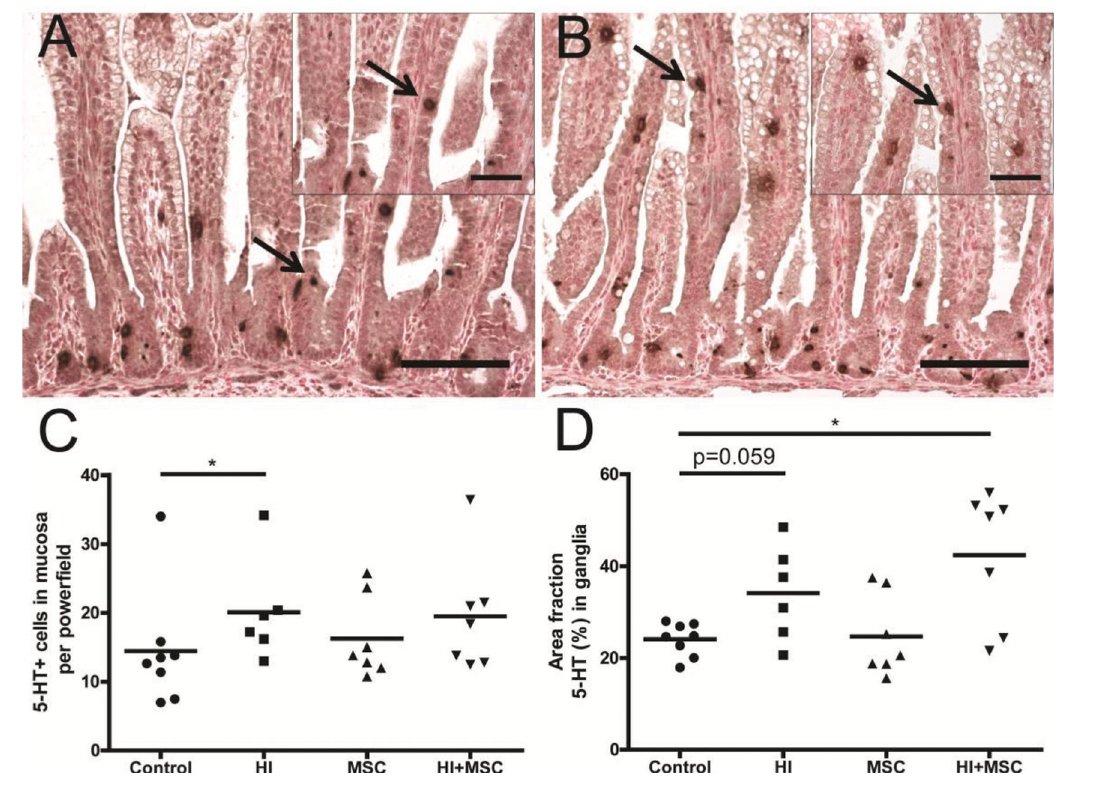
figure 10. Increased 5-HT in fetal intestinal mucosa 7 d after HI. Representative intestinal sections of (A) control and (B) HI animals were stained by immunohistochemistry for 5-HT. For each experimental group, 5-HT + cells (arrows) in mucosa (C) were counted and the 5-HT- positive area in myenteric ganglia (D) was measured. The mean cell counts in mucosa and area fraction (%) per ganglion per animal are given. The scale bar in panels represents 100 μ m. The scale bar in insets represents 50 μ m. * p < 0.05. Significance between control and HI group in panel D was tested by t test, and p value is